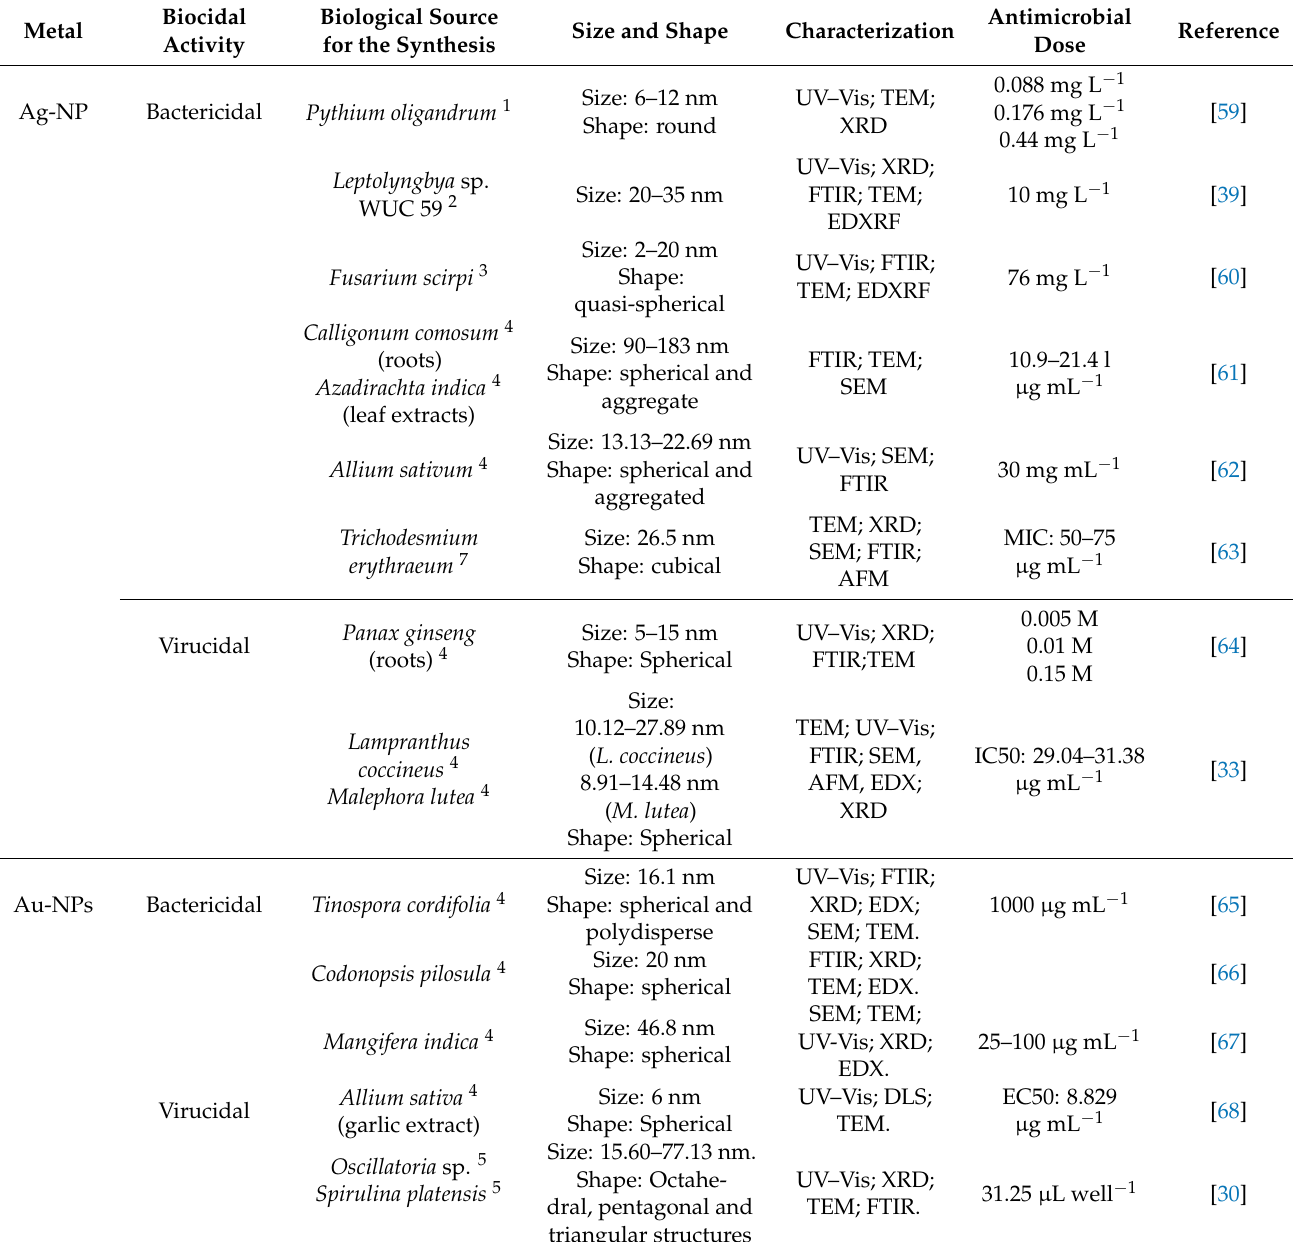
Table 1. Selected examples of biogenic metal-based NPs with antimicrobial activity synthesized by different biological sources. According to source: 1 = Oomycete, 2 = Cyanobacterium, 3 = Fungi, 4 = Plant, 5 = Algae, 6 = Bacterial, 7 =